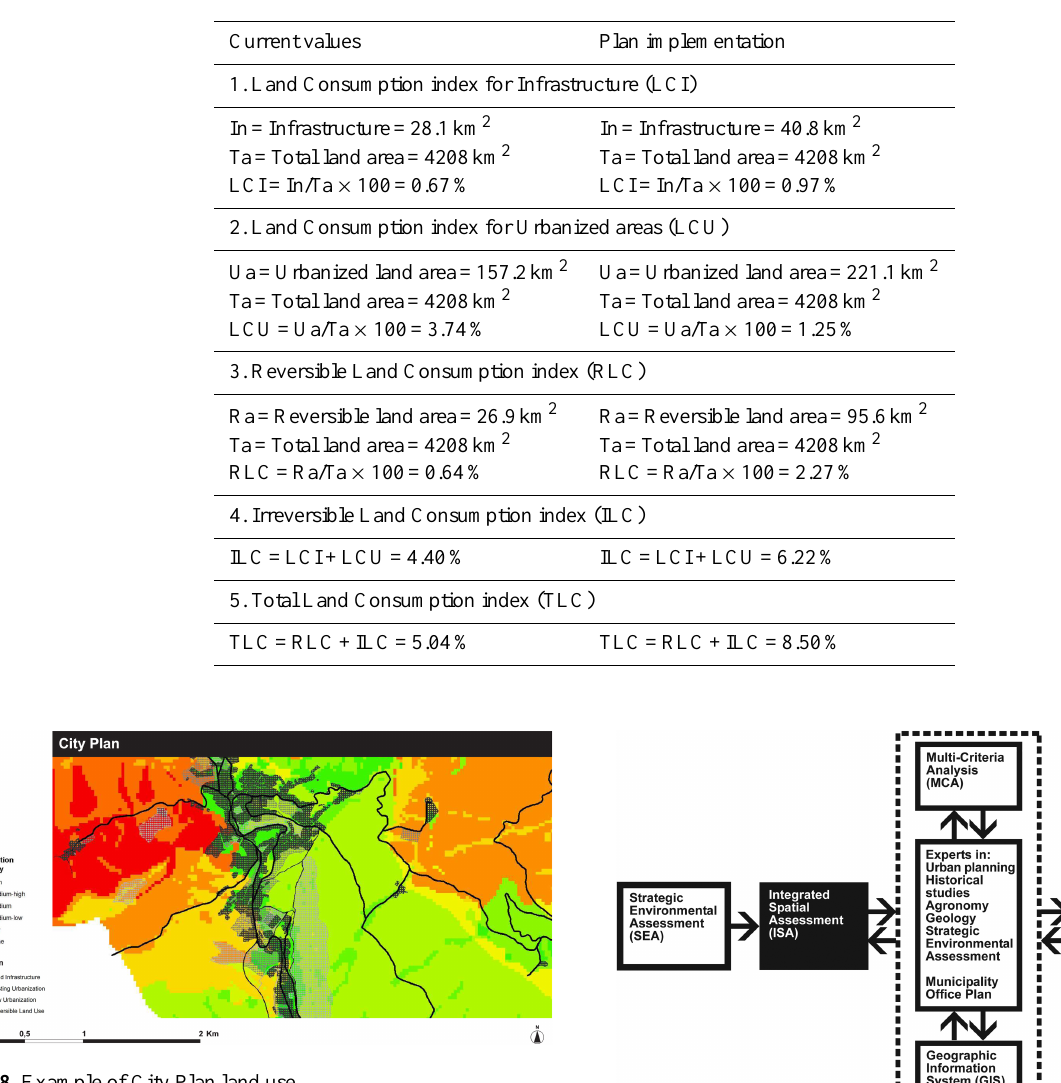
Table 3. Indexes of land consumption.